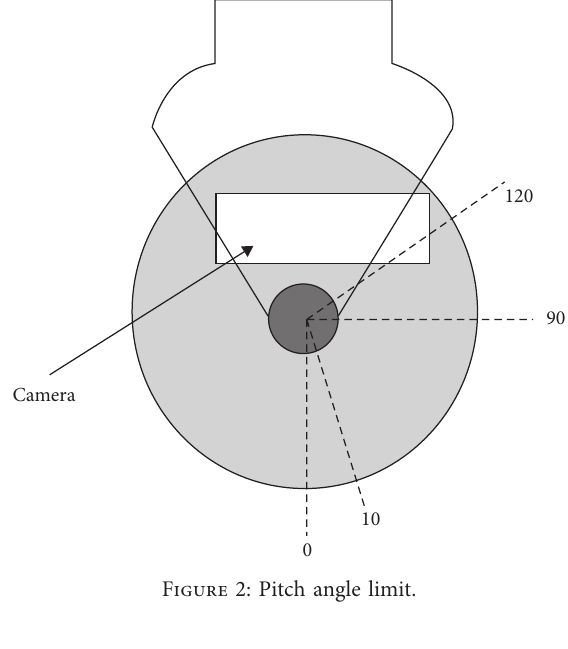
Figure 2: Pitch angle limit.